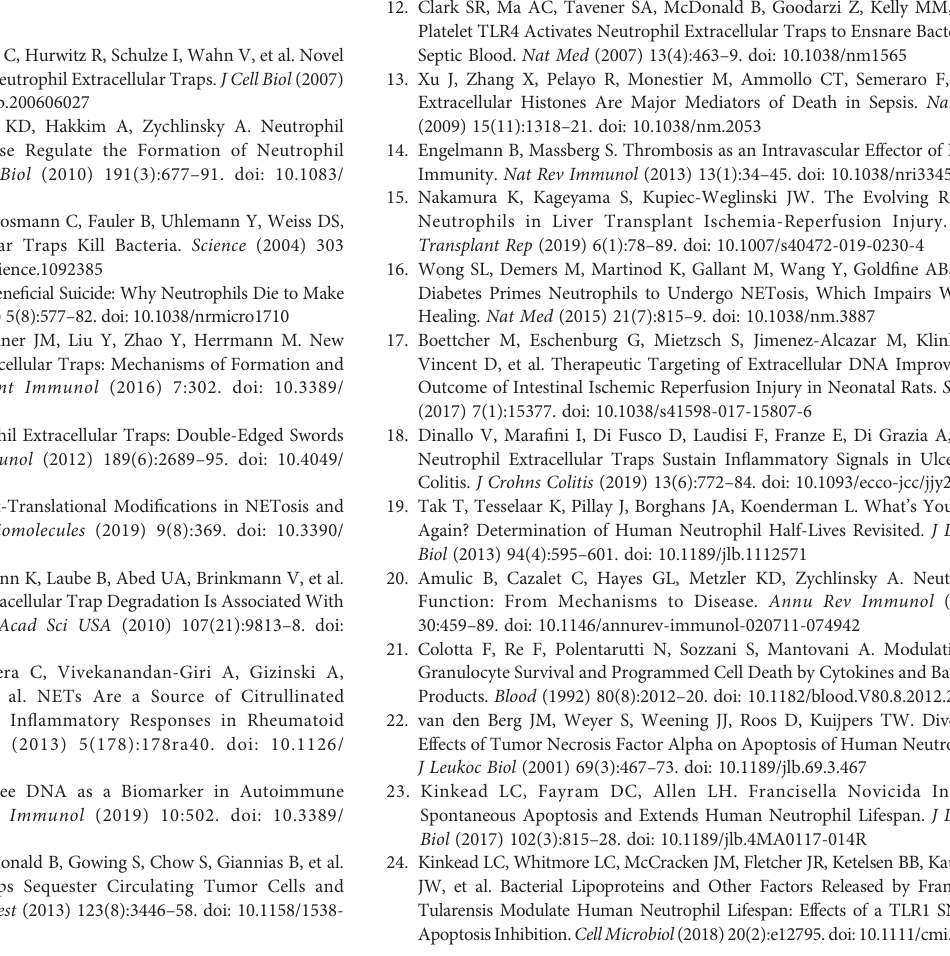
Supplementary Figure 3 | Representative FACS dot plots for survival and histograms for activation after TNF- a treatment. Neutrophils were incubated with several amounts of TNF- a or medium only and analysed after 6 h (A) , 24 h (B) , 48 h (C) and 72 h (D) incubation by staining withAnnexin-V and PI. Double negative cells (green) are considered vital, Annexin-V pos (orange) are considered in apoptosis and double positive cells (red) are considered dead. Expression of CD11b and CD66b was analysed by FACS analysis after incubation of neutrophil granulocytes with TNF- a or medium only for 6 h (A) , 24 h (B) , 48 h (C) and 72 h (D) . Every dot plot or histogram consists of 10.000 events. Gating cut-off was set by measurement of unstained controls for PI and Annexin-V or iso controls for CD11b and CD66b. Supplementary Figure 4 | Immuno fl uorescence imaging of neutrophils. Immuno fl uorescence imaging showed no extracellular DNA of neutrophils incubated with G-CSF, LPS or TNF- a . After fi xation, DNA was stained with 1 µg/mL DAPI (blue). Images represent areas with comparable cell density at 40× magni fi cation. Supplementary Table 1 | Cellcountafterincubationtimeisdisplayedinrelationto 3,5 × 10 5 cells seeded at the beginning. Neutrophils were incubated with mentioned doses of G-CSF, LPS, TNF- a or Medium only and counted after 6 h, 24 h, 48 h and 72 h of incubation with a haemocytometer. Values represent means ± SD of n =